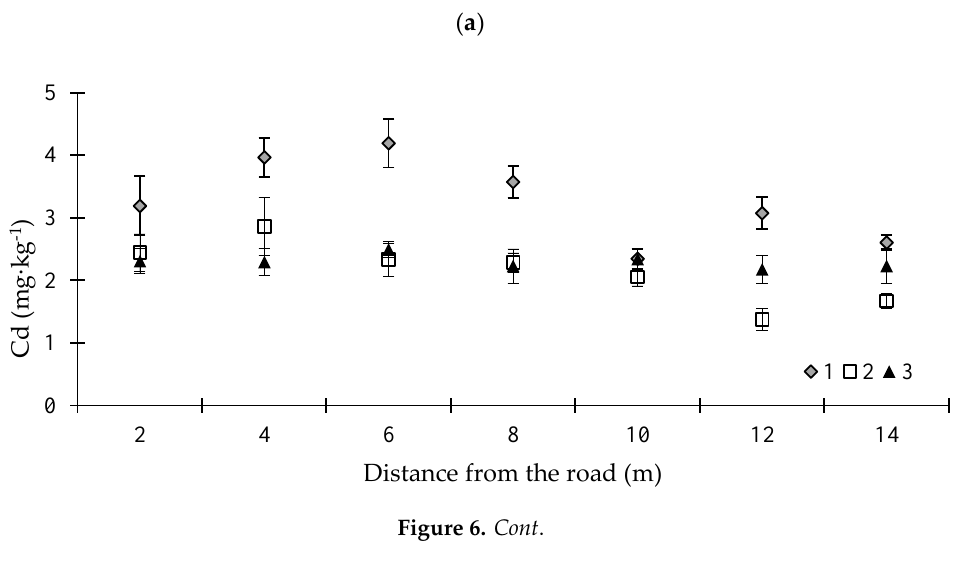
Figure 6. Cadmium concentrations in moss ( P. schreberi ): ( a ) distance from the road at sampling location, ( b ) average Cd content at different locations, and ( c ) Cd content at different distances from the road (average values from three locations) ( n = 5, ±standard deviation). Different letters above bars representing lead concentrations for different locations or for different distances from the road indicate that they differed significantly (Tukey’s test, p < 0.01). Table 2 presents the correlation coefficients between the contents of potentially toxic elements in moss. Strong positive correlations were noted between all analyzed potentially toxic elements in P. schreberi. The highest correlation ( r = 0.92) was observed between Zn and Cd and the lowest between Ni and Cd and between Pb and Cd ( r = 0.65 and r = 0.68, respectively). Similar correlations between Zn, Ni, Pb, and Co in the road dust were shown in a study by Johansson et al. [33]. A very high correlation ( r = 0.96) between Pb and Cd (emitted by road traffic) was demonstrated by Mazur et al. [45]. Sudip et al. [46] found that in road dust studied over four months, the correlation coefficients ( r ) between Zn, Cd, Ni, and Pb ranged from 0.43 to 0.74 and were determined by distance from the curb. In this study, there was a very strong, negative correlation between content of potentially toxic elements in P. schreberi and the distance from the emissions source at a given sampling location. This means that the content of potentially toxic elements decreased with distance from the road at different locations. In addition, an analysis of variances showed a statistically significant influence of the analyzed factors (location and distance from the road) and their interactions on the concentration of potentially toxic elements in P. schreberi (Table 3).